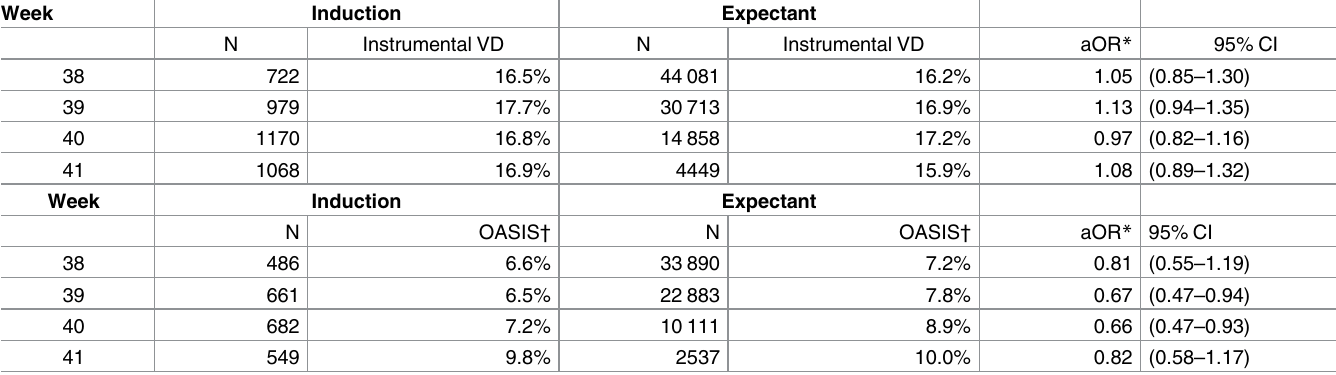
Table 3. Risk of instrumental vaginal delivery and obstetric anal sphincter injury (OASIS) in pregnancies with large for gestational age infants depending on management with induction at 38 to 41 completed gestational weeks or expectant management with labor at next gestational week or later.